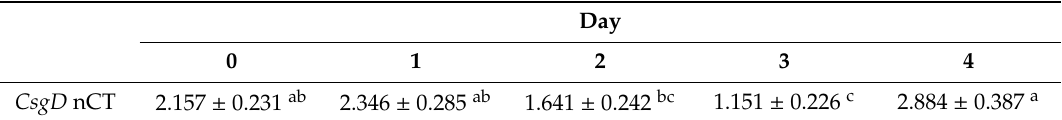
Table 1. Changes in expression of the gene CsgD from planktonic cells used to form Salmonella pellicles over a 4-day time period 1,2 .